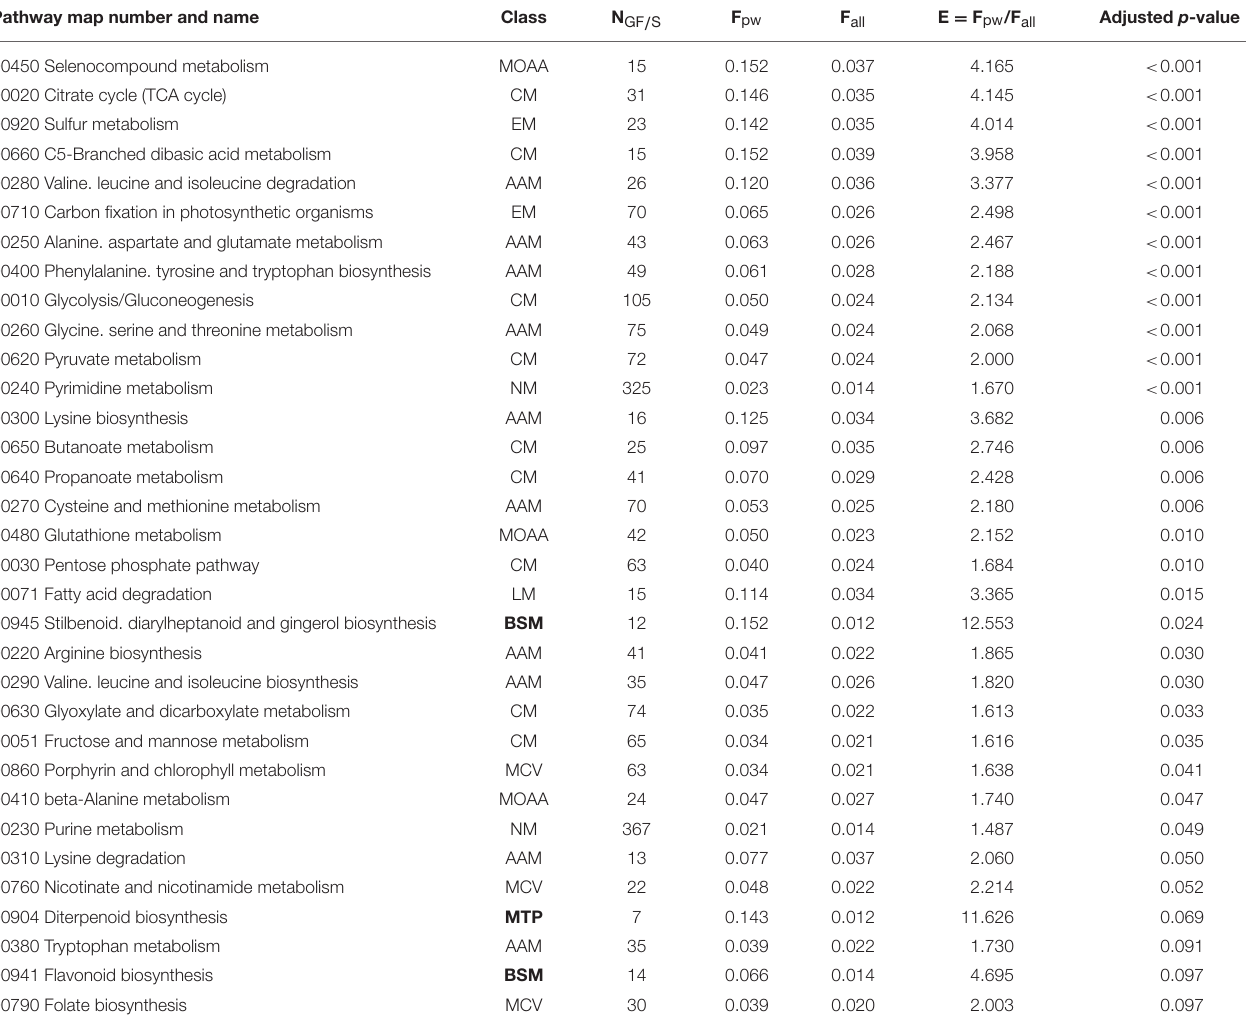
TABLE 3 | Statistics of metabolism pathway assignments and phylogenetic profile identities of gene families and singletons. Pathway map number and